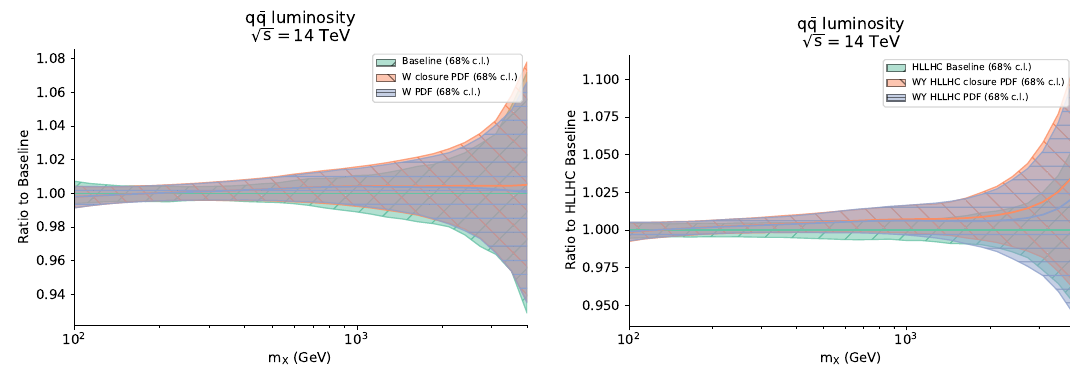
Figure 14 . The q ¯ q luminosity obtained from the closure tests when the experimental central values are modified to encode a specific SMEFT benchmarking scenario (“closure PDF” in orange), compared to the results of the simultanoues fits (“PDF” in blue) normalized to the corresponding baseline (in green). Shown in the left panel is the W = 1 × 10 − 3 scenario while the ( W, Y ) = (1 , − 1) × 10 − 4 scenario is displayed in the right